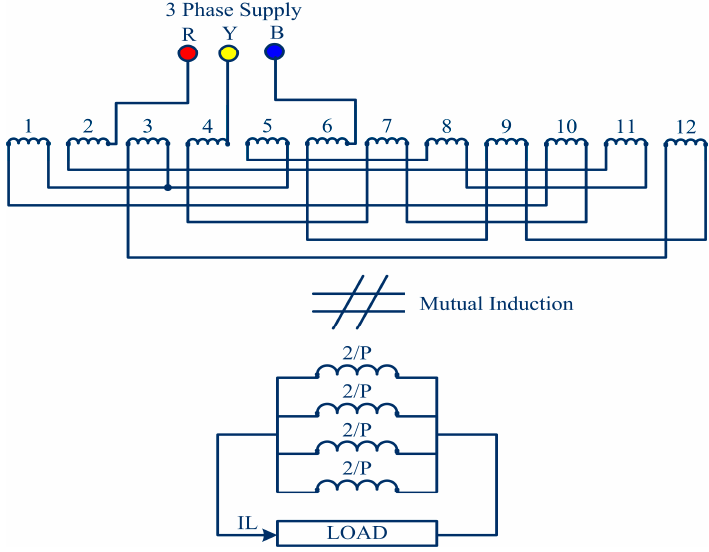
Figure 2. Proposed induction motor winding arrangement working as a welding transformer.